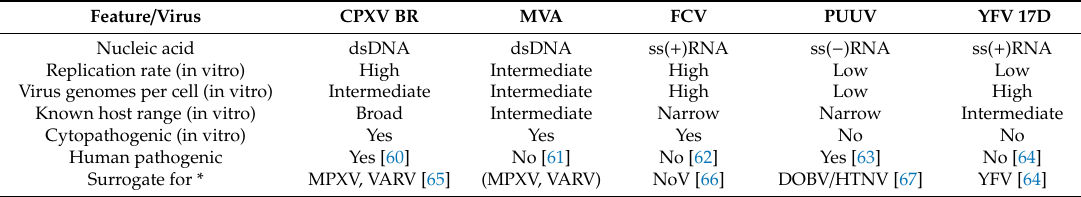
Table A3. Characteristics of viruses based on experimental